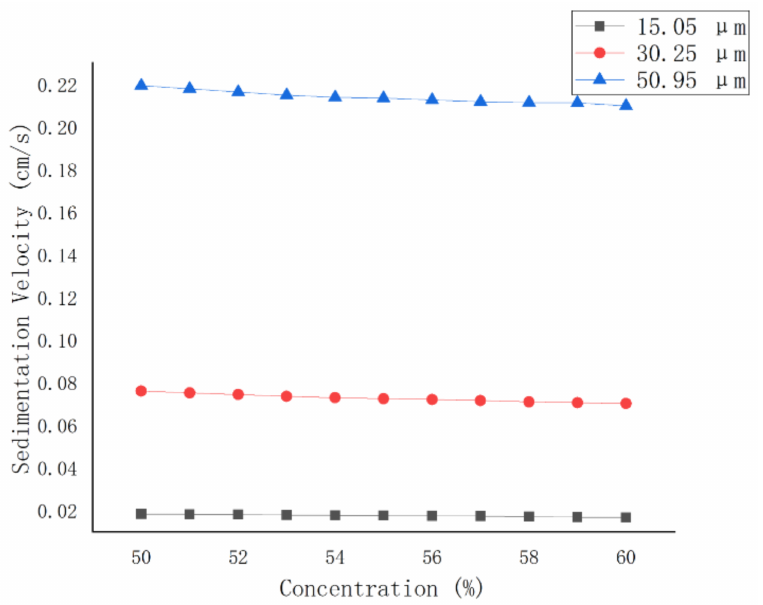
Figure 9. Relationship between the concentration and sedimentation